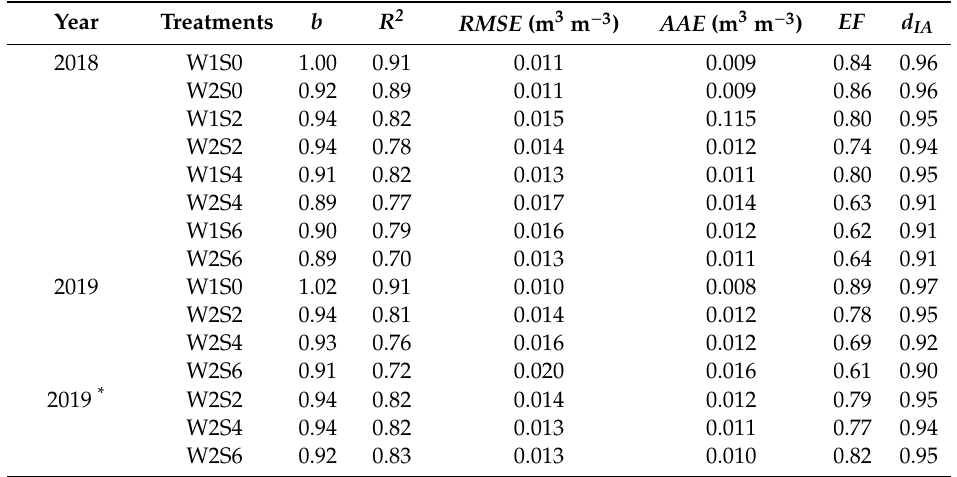
Table 2. Indicators of goodness of fit of soil water content ( SWC ) related to the SIMDualKc model calibration and validation for